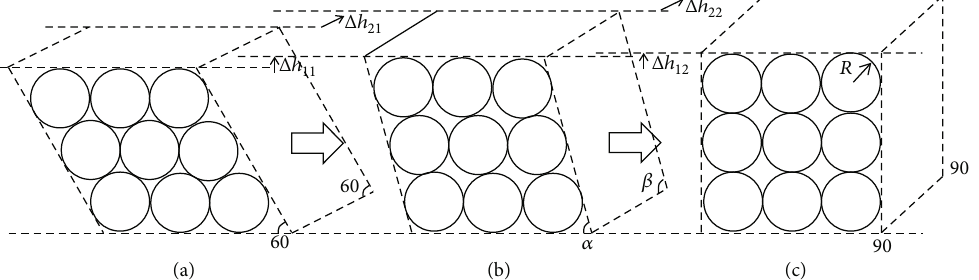
Figure 9: 3D evolutions of the shear dilation and permeability improvement